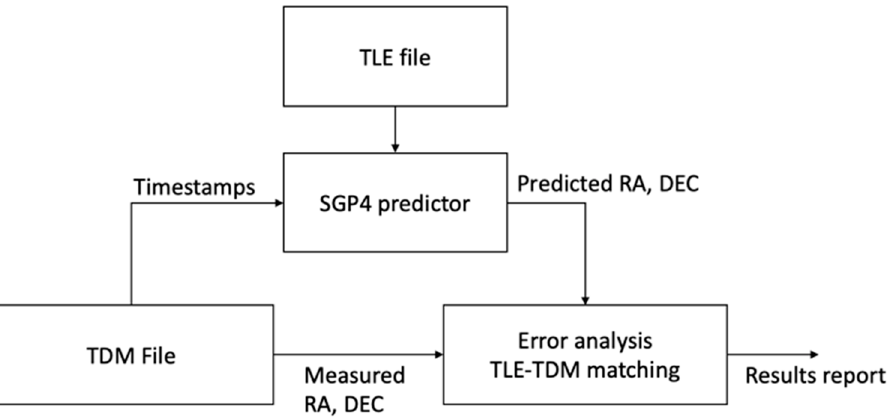
Figure 18. The TLE-based validation methodology.